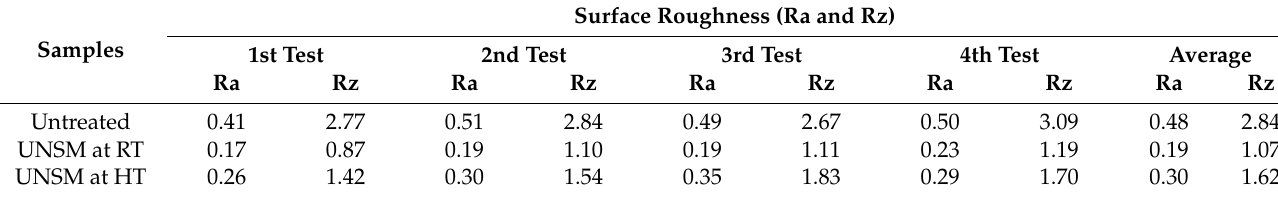
Table 3. The surface roughness